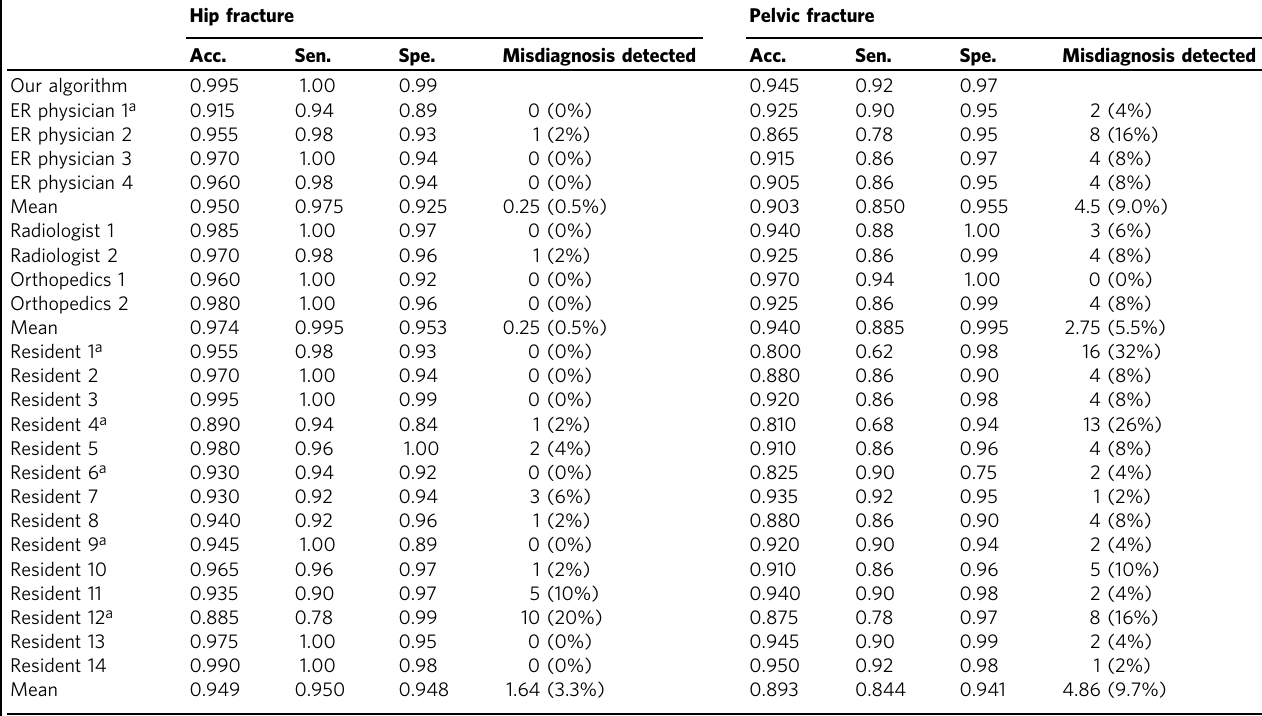
a Signi fi cant difference between a physician and the algorithm on McNemar ’ s test. Abbreviations: Acc accuracy, Sen sensitivity, Spe speci fi